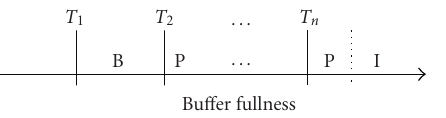
Figure 2: Example settings of dropping thresholds for